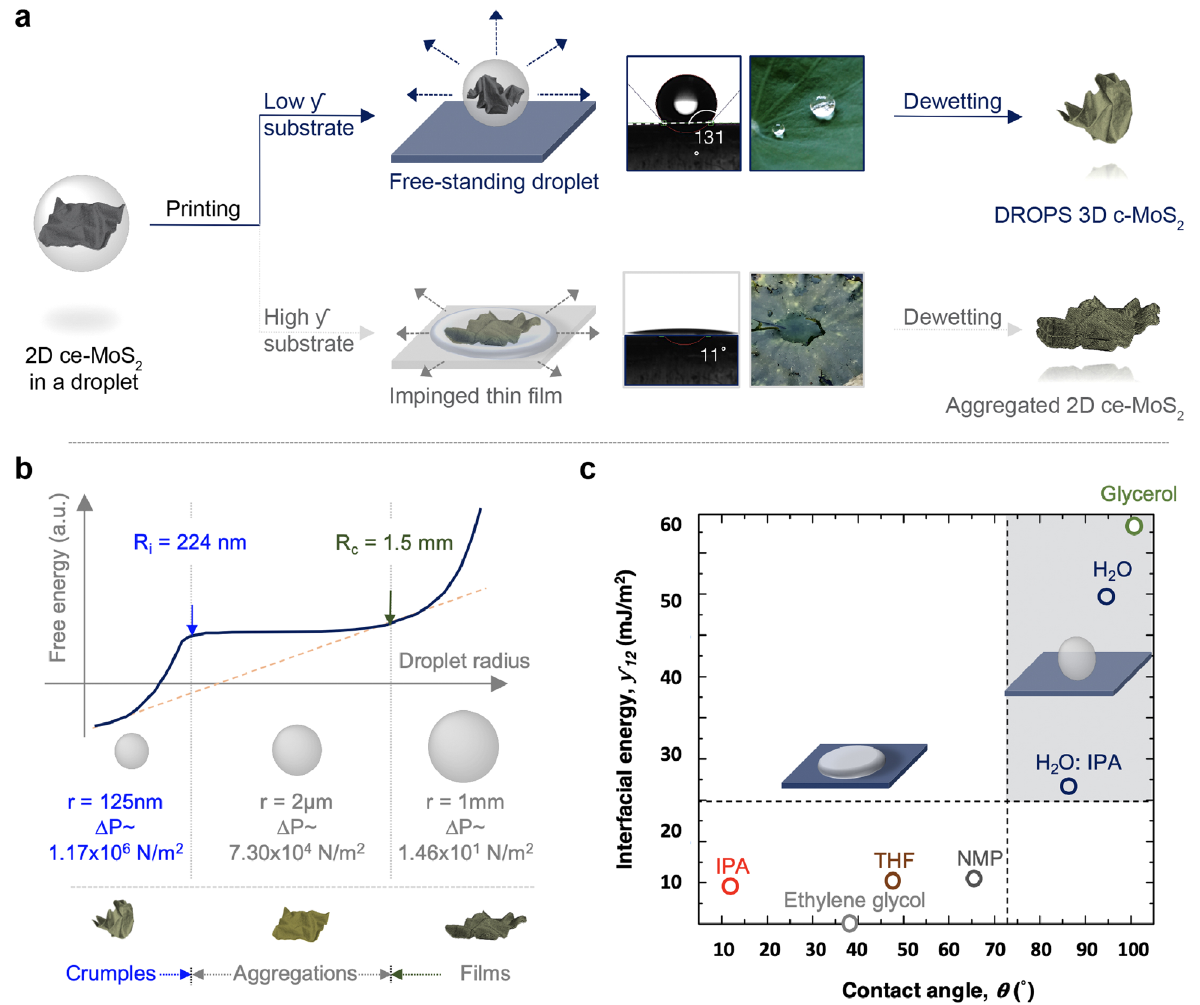
Fig. 4 Mechanistic study of DROPS. a Schematic representation shows distinctively different dewetting dynamics of nano-droplets driven by different interfacial energies at liquid/solid interfaces. b The diameters of incoming droplets have profound implications on the Laplace pressures ( Δ P ) and associated dewetting outcomes. c Contact angles of an array of polar solvents as a function of interfacial energies allow us to deduce the working combinations of the formation of spherical droplets on a HOPG substrate (shaded area, where contact angle >85 ˚ and interfacial energy >25 mJ/m 2